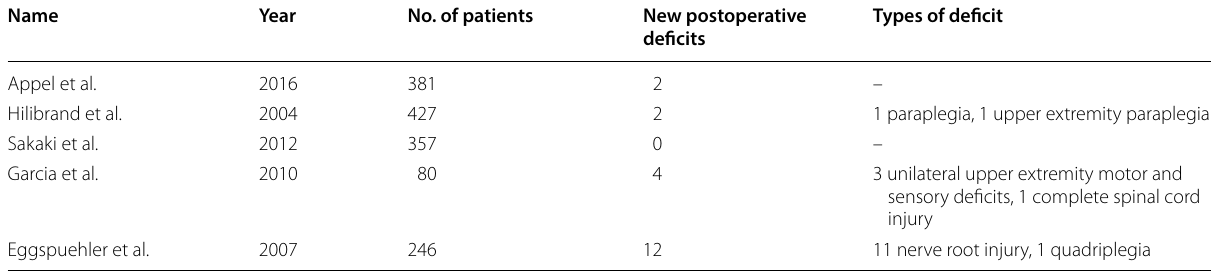
Table 5 Clinically assessed postoperative